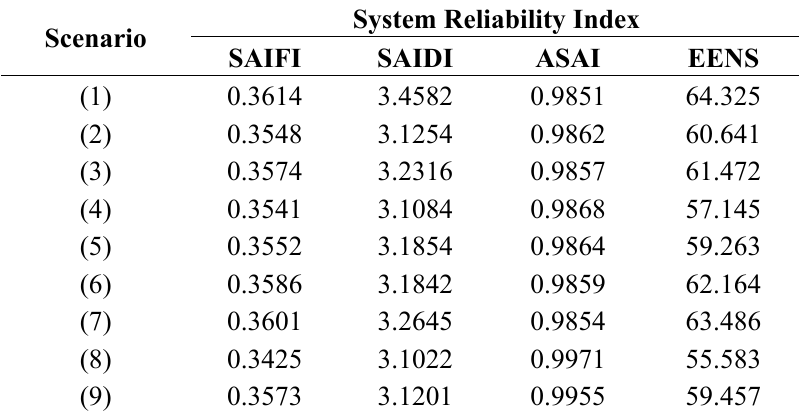
Table 1. System reliability index comparison in different system scenarios.